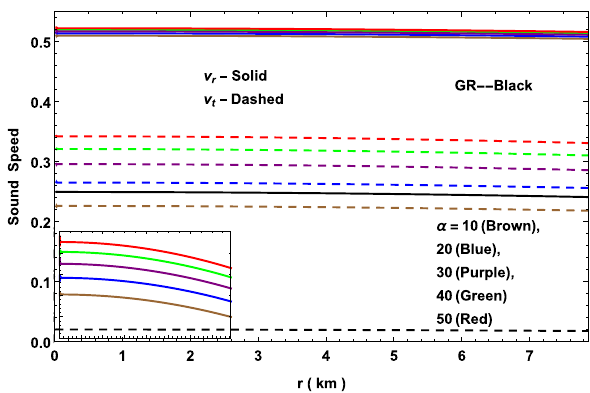
Fig. 7 Variation of sound speed for 4U 1538-52 using the parameter provided in Table